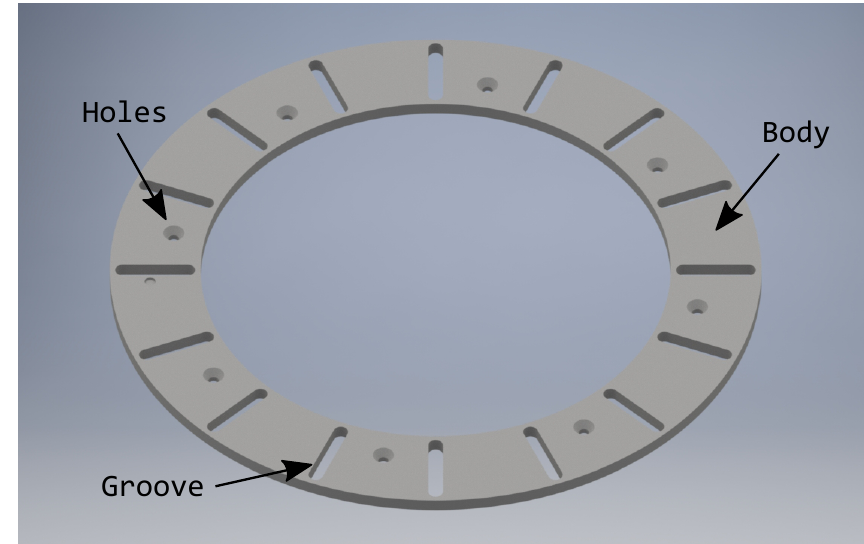
Figure 8. Lower ring.